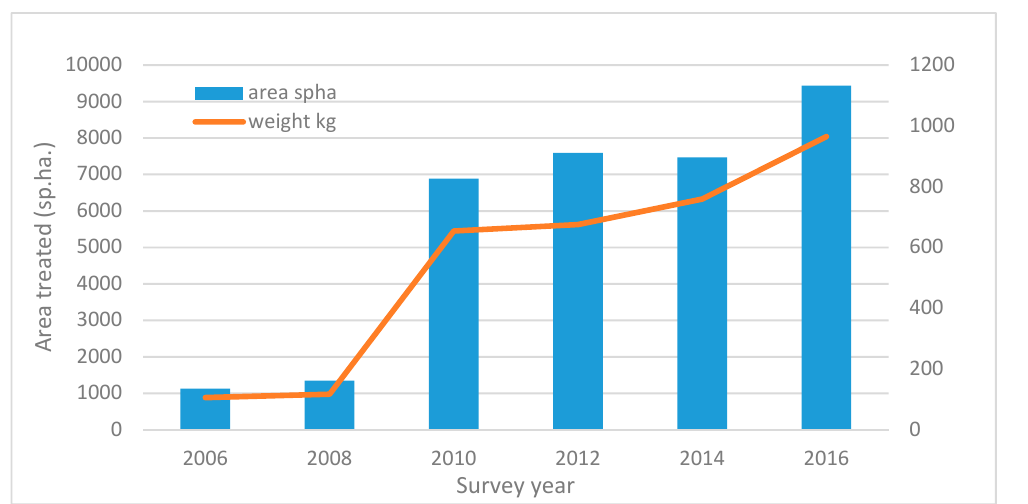
Figure 7. Application intensity (kg/ha) of the major pesticide groups to arable crops in Northern.